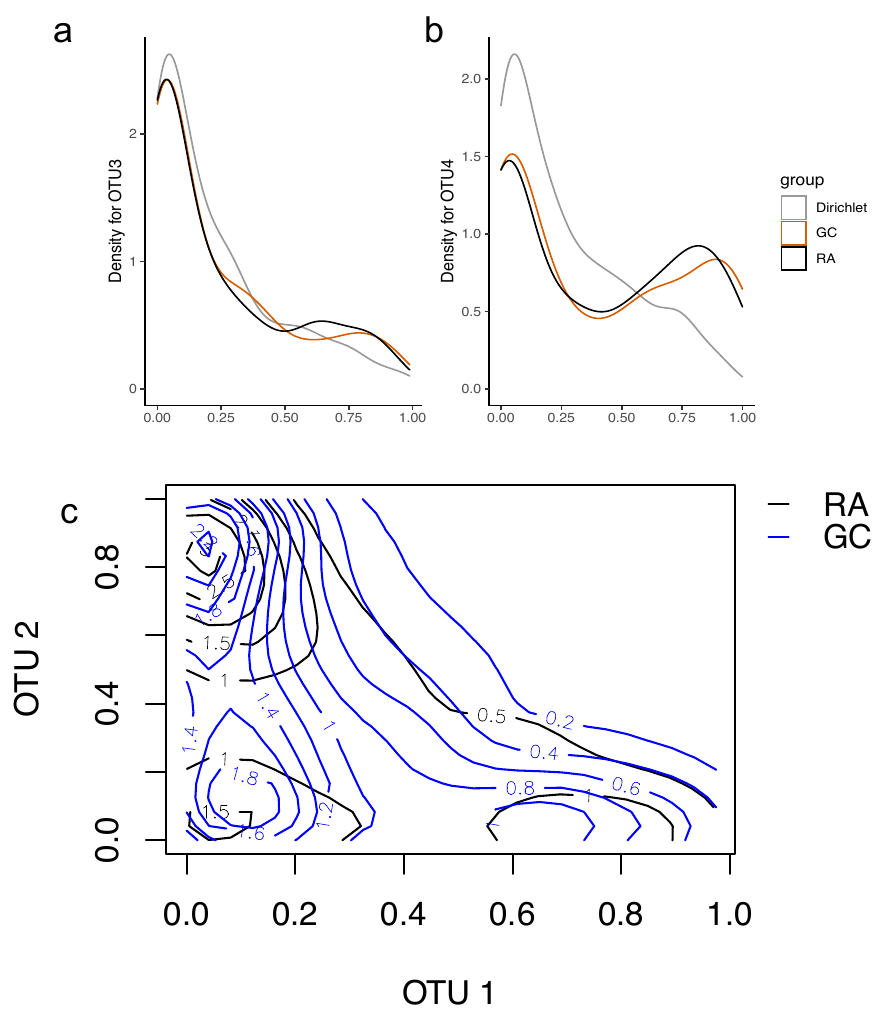
Figure 4. Multivariate distribution via Gaussian copula of taxa Clostridium and Escherichia. The upper panel ( a , b ) illustrates the estimated marginal density functions: the black line is estimated by the samples, the gray line by Dirichlet distributions, and the orange line is by Gaussian copulas. The lower panel ( c ) shows the contour plots of the estimated Gaussian